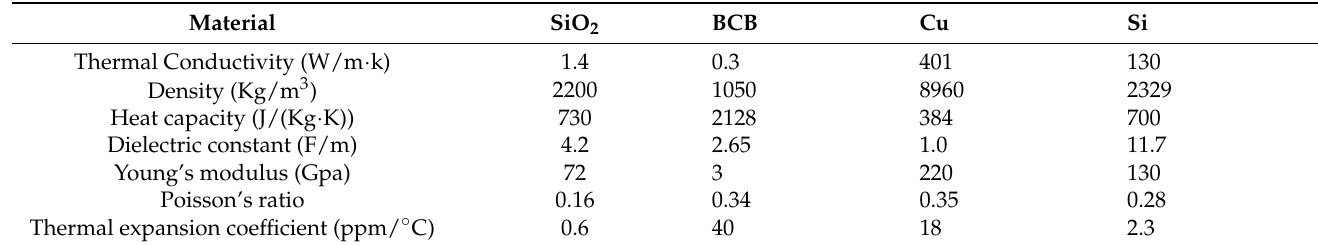
Table 1. Materials and related physical